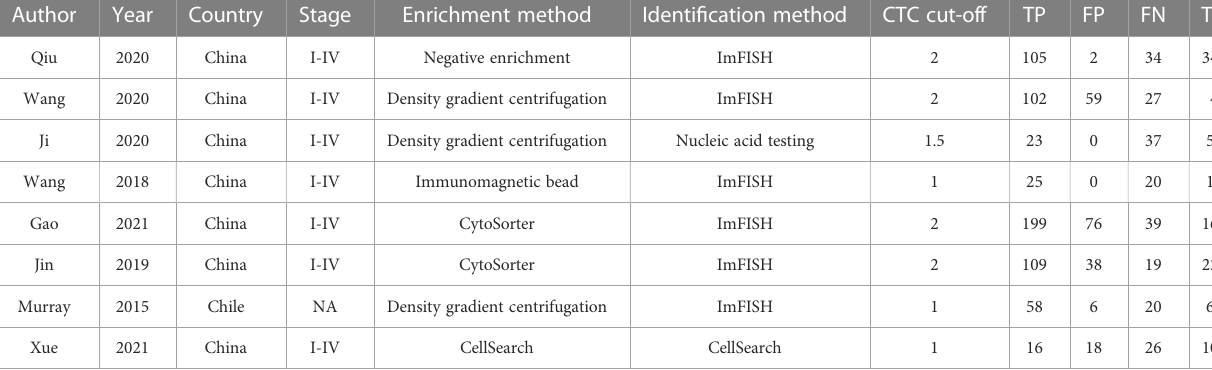
TABLE 1 Main characteristics of studies included in the meta-analysis of the diagnostic accuracy of CTCs detection in BC.